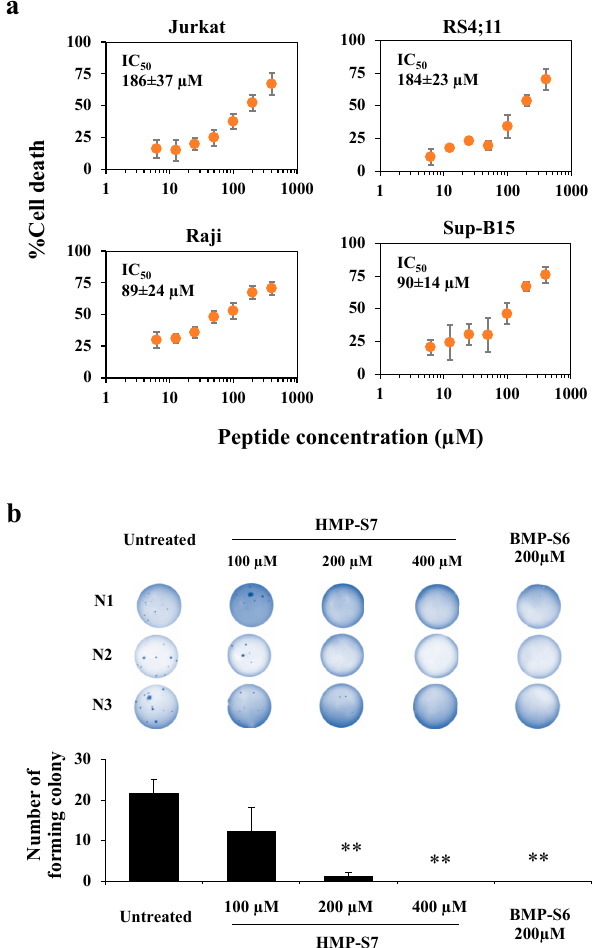
Figure 5. The inhibitory action of HMP-S7 on leukemic cells. ( a ) Four leukemic cell lines, namely Jurkat, Raji, RS4;11, and Sup-B15 cells, were treated with HMP-S7 at various concentrations (0–400 µM) for 24 h, and the % cell death (mean ± SD) was determined using trypan blue exclusion assay; ( b ) effects of HMP-S7 (100, 200, and 400 µM) and the positive control BMP-S6 (200 µM) on the colony forming ability of Jurkat cells (three independent experiments; N1–N3). After the treatment with the test peptide for 24 h, cell suspensions were allowed to form colonies in soft agar for 20 days. The colonies in the soft agar were stained with crystal violet and counted. ** p < 0.01 compared to untreated condition ( n = 3 biological replicates).